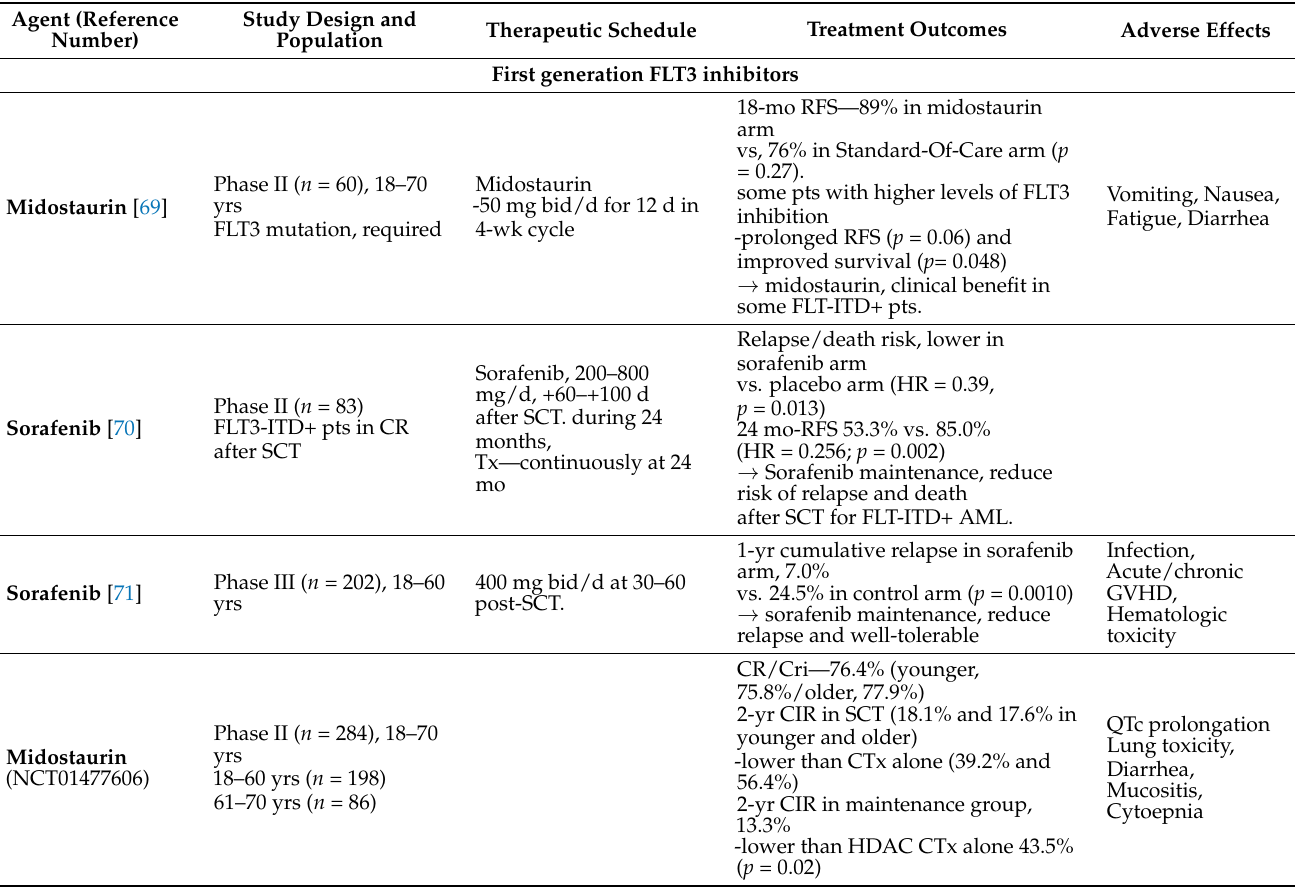
Table 3. Clinical trials of FLT3 inhibitors as maintenance therapy after stem cell transplantation in AML